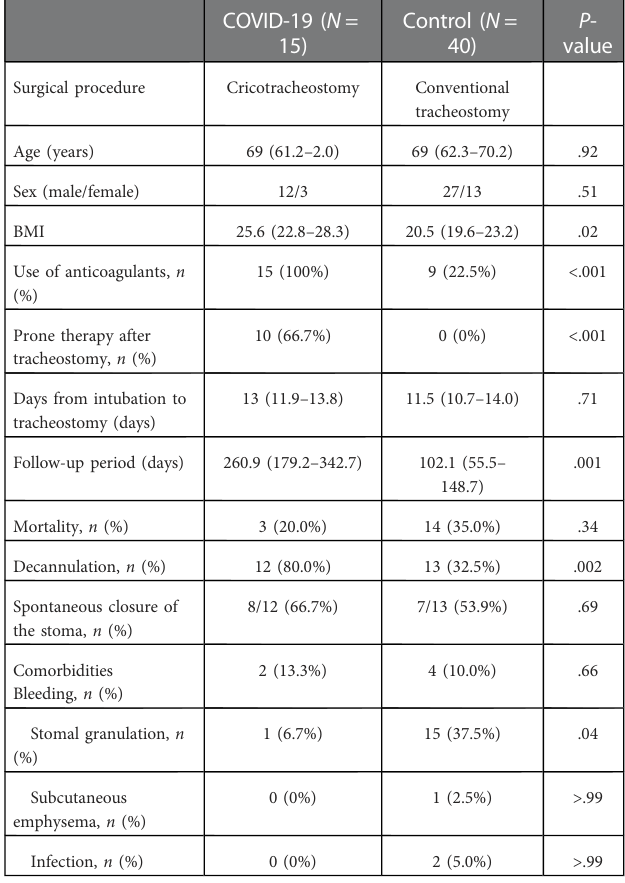
TABLE 1 Clinical characteristics of the